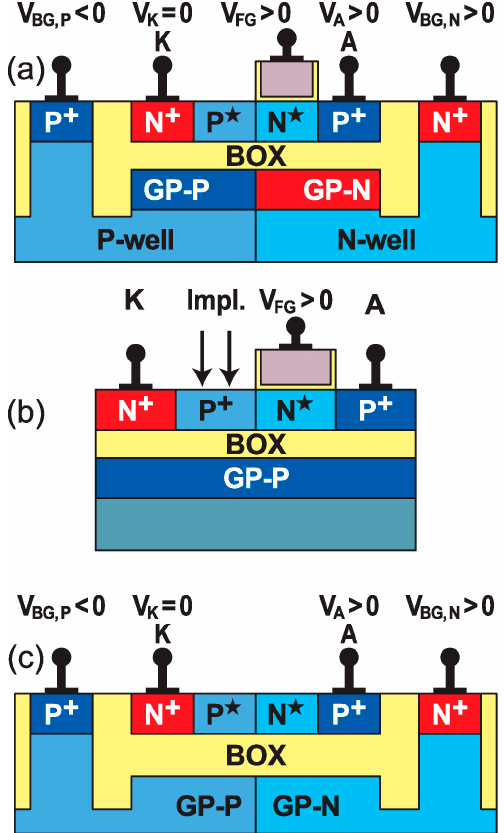
Figure 3. Z 2 –FET variants fabricated with FD-SOI technology: ( a ) dual ground-plane, ( b ) partially doped, and ( c ) gateless Z 3 –FET. Physically-doped ungated section (Figure 3b): The idea here is to eliminate the back-gate action. Boron implantation replaces the P* electrostatic doping, without af-